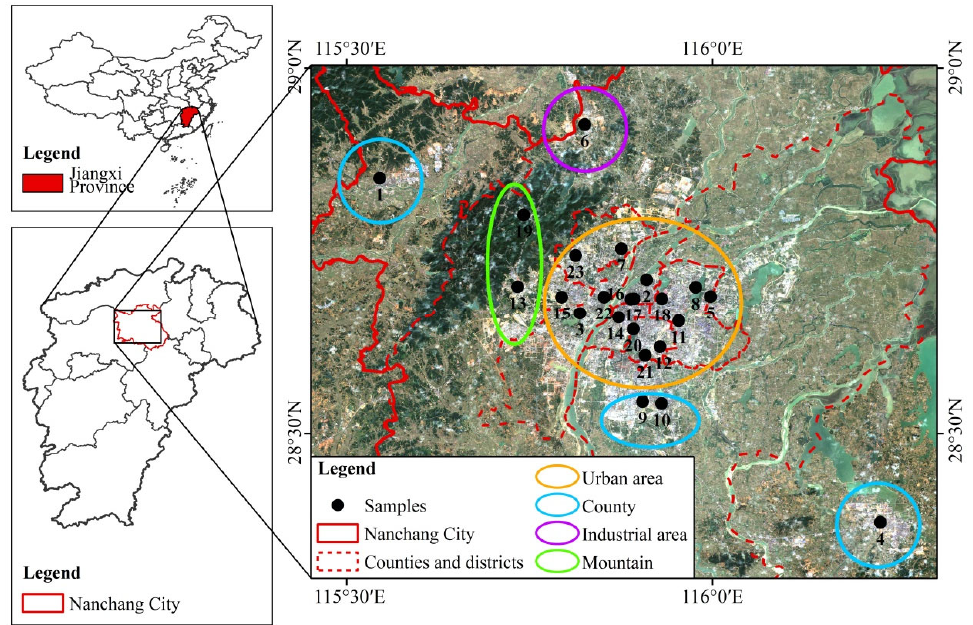
Figure 1. Locations of the monitoring stations of the Air Quality Monitoring Network in Nanchang. Notes: 1, Environmental Protection Agency of Anyi County; 2, Environmental Protection Agency of Donghu District; 3, Nanchang